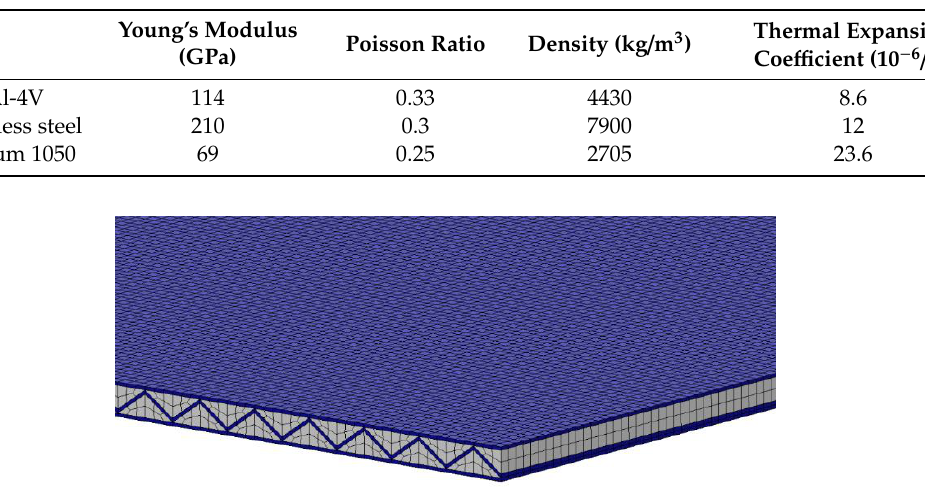
Table 2. Material properties of base material of face sheets and corrugated members [19].